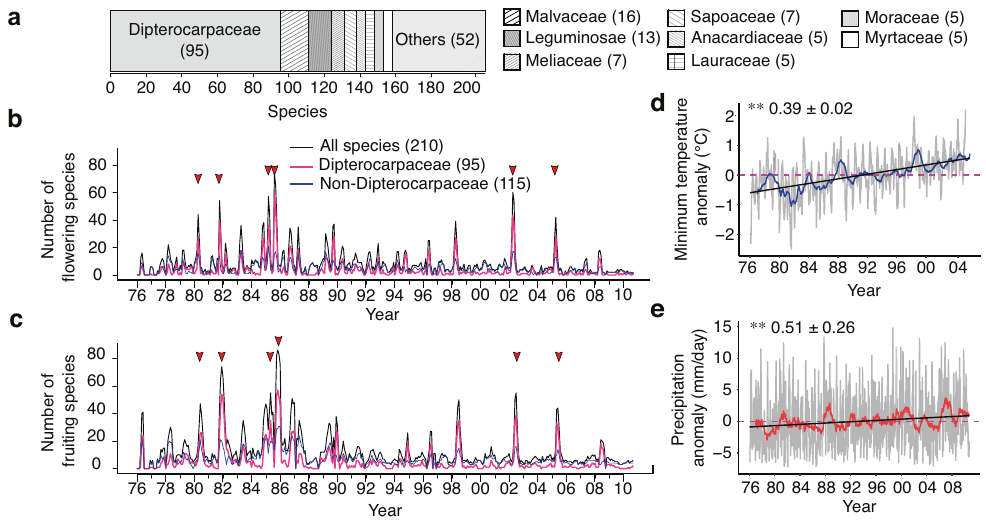
Fig. 1 Flowering and fruiting records for 210 tropical tree species. a Composition of species included in the phenology monitoring. The numbers in brackets indicate the number of species. The numbers of fl owering ( b ) and fruiting ( c ) species among all species (black), dipterocarp species (pink), and non-dipterocarp species (blue) are shown. The horizontal arrows indicate mass fl owering events, with >20% of monitored species blooming as fl owers or fruits. Note that the number of monitored species was not always 210 due to missing values. d A plot of the minimum temperature anomalies smoothed with the 30-day (gray) and 12-month (blue) moving averages. e A plot of precipitation anomalies smoothed with the 30-day (gray) and 12-month (blue) moving averages. The black lines in d and e show the results of the linear regression of daily climatic variables, whereas the dashed pink lines indicate the normalized mean of each climatic variable over a monitoring period (1976 – 2005 for the minimum temperature and 1976 – 2008 for precipitation). The symbols indicate the results of the Mann – Kendall test (two-sided, n = 400; Supplementary Table 1). ** P < 0.01. The mean change rate ± 95% of the con fi dence interval per decade is given for each